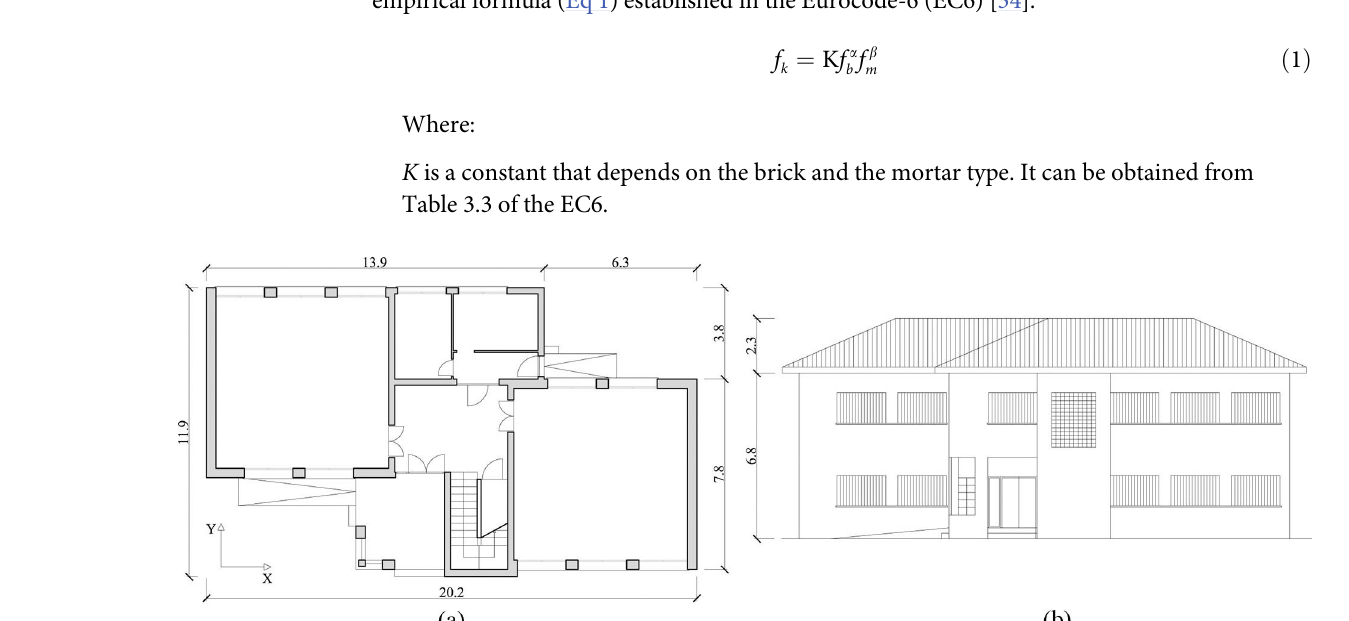
blueprints. The characteristic compressive strength ( f empirical formula (Eq 1) established in the Eurocode-6 (EC6) [34].